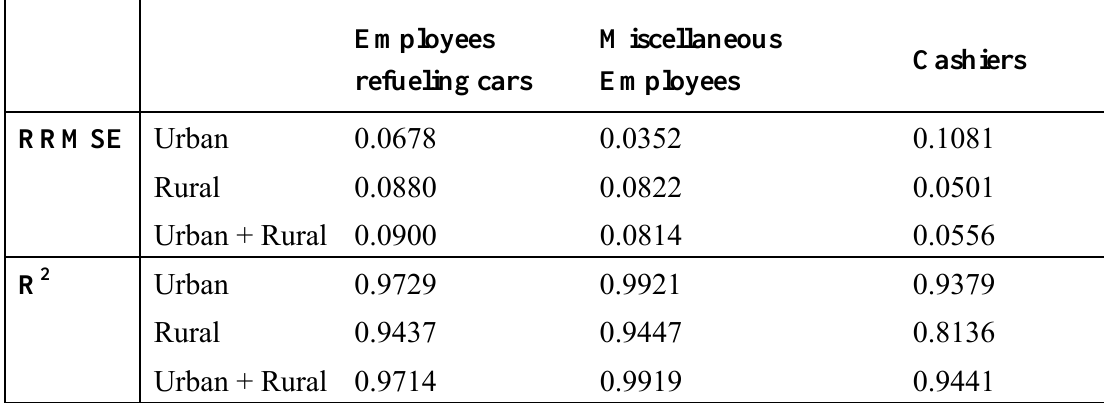
Table 2 . ANN exposure model evaluation